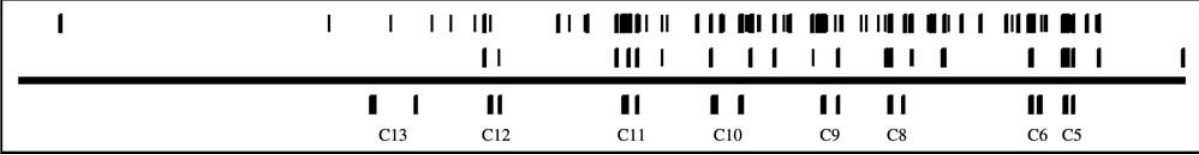
Figure 3 - Sequence conservation in HoxC cluster. Thick horizontal line indicates the range which has been analyzed, with position of HoxC genes indi- cated below it (all Hox genes have two exons). The bars right above the line indicate the positions of larger (50-400 bp) environments conserved at, or